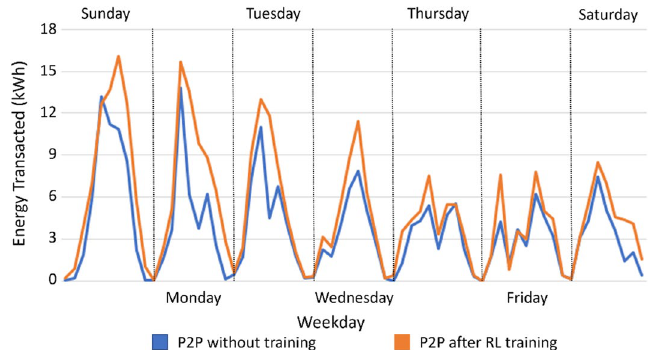
Fig. 11 Energy transacted in the P2P market before and after the RL